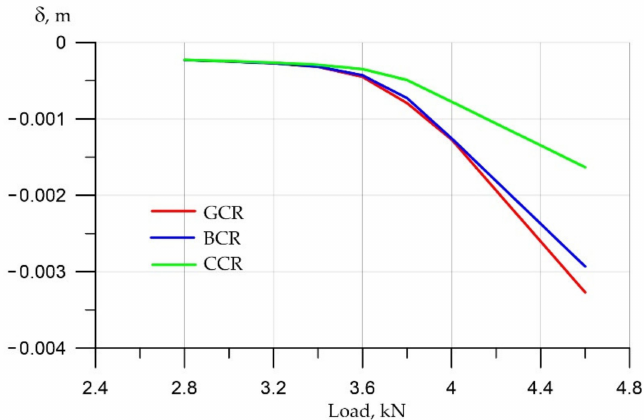
Figure 14. Dependence of beam deflections on applied